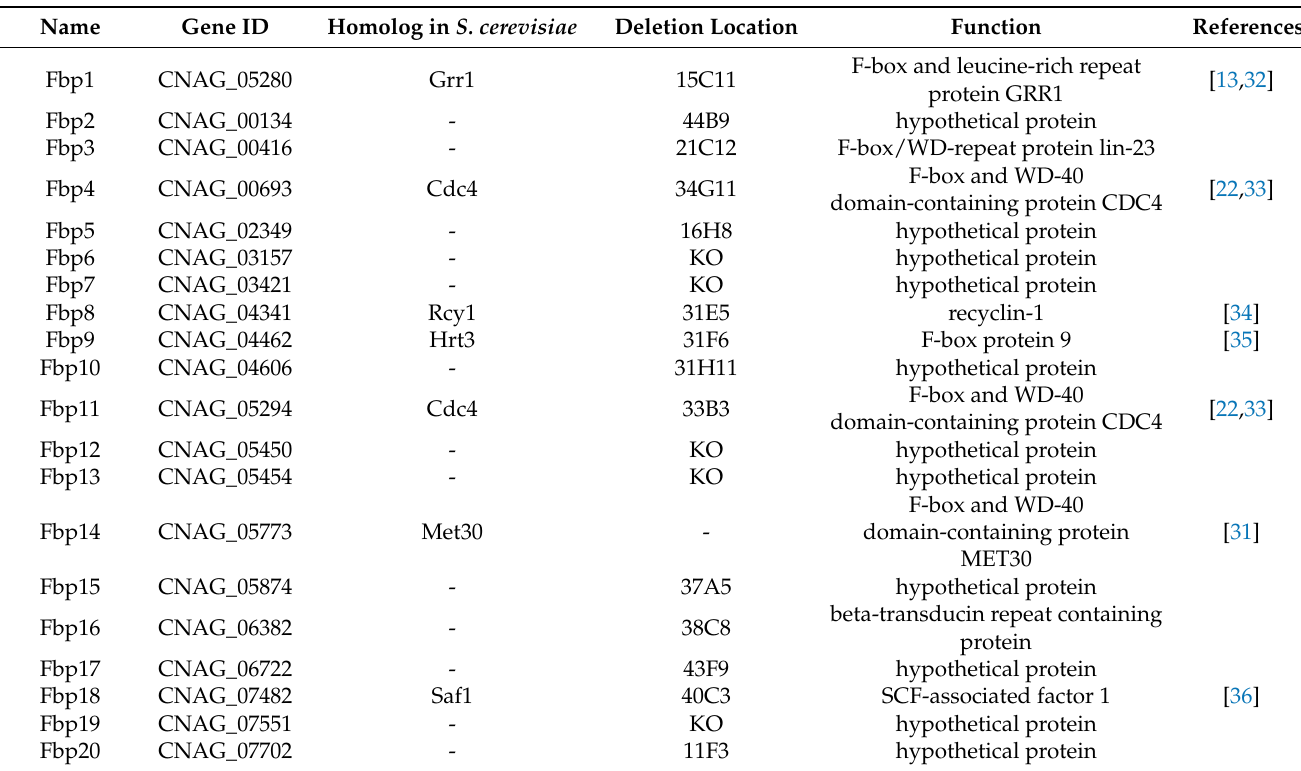
Table 1. The F-box proteins in Cryptococcus neoformans